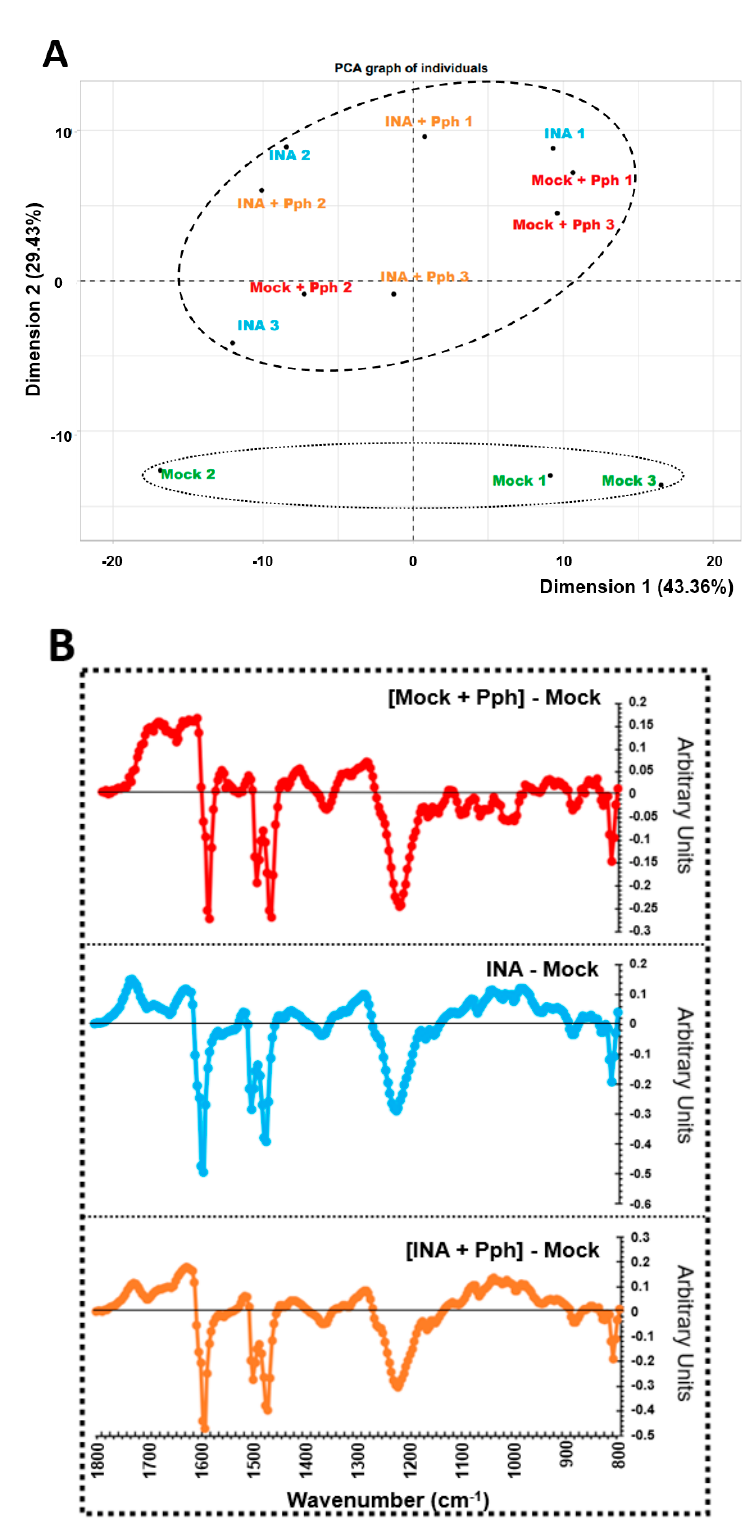
Figure 3. Cell wall fingerprinting. ( A ) Principal Component Analysis obtained from FTIR spectra of crude cell walls extracted from leaves of Mock, Mock + Pph, INA, and INA + Pph common bean plants. Each dot represents a biological replicate obtained in each of the 3 independent experiments carried out. PCA is plotted with dimensions 1 and 2, which explained the 43.36% and 29.43% of the total variance, respectively. ( B ) Average FTIR difference spectra obtained by digital subtraction of the Mock CW spectra from the CW spectra of the other treatments.